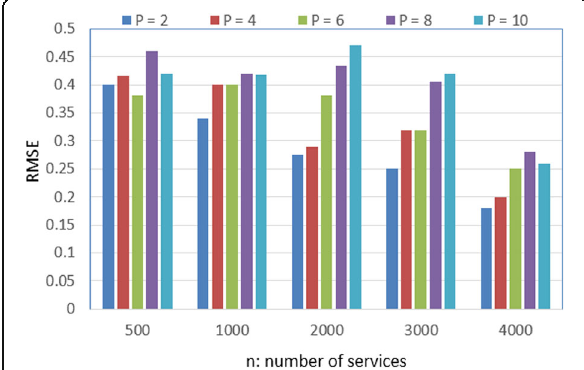
Fig. 3 Accuracy of Rec MPS w.r.t. n and P ( m = 142) . P = 2, P = 4, P = 6, P = 8, P = 10